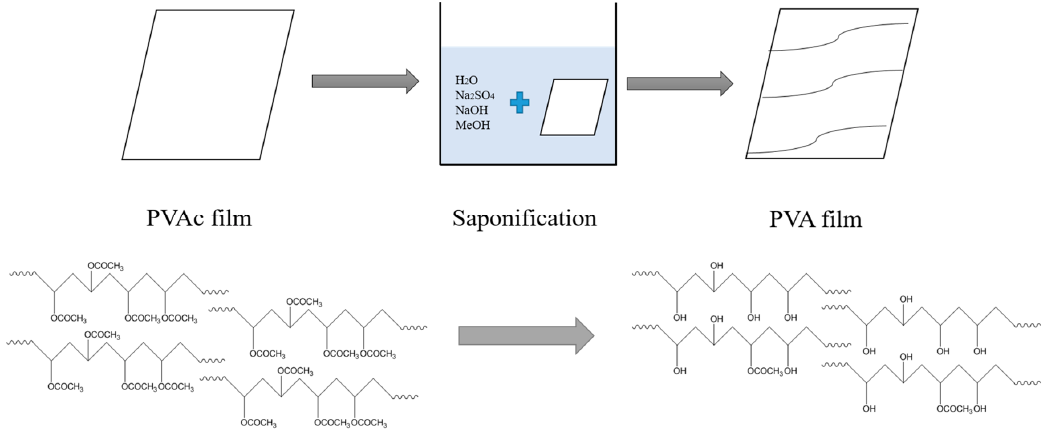
Figure 1. Schematic of the preparation of PVA by heterogeneous saponification.